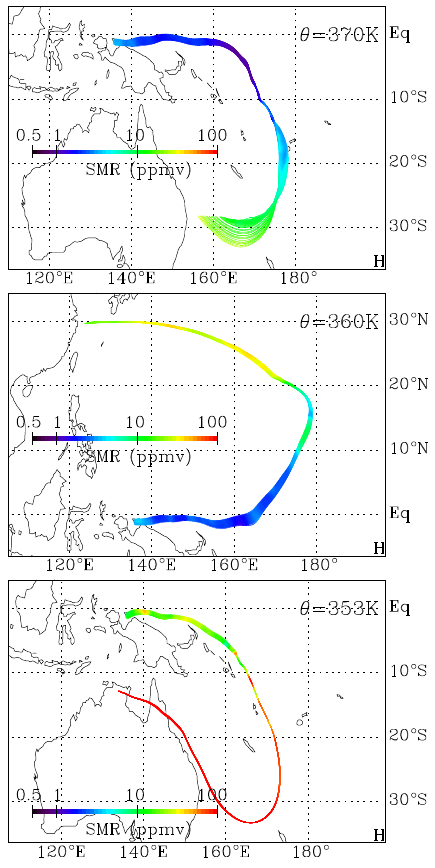
Fig. 10. Seven-day isentropic backward trajectories started from Biak on (top) 370, (middle) 360, and (bottom) 353 K surfaces corresponding to the observation shown in Fig. 8. Trajectories are colour-coded by saturation mixing ratio estimated from ECMWF analysis.